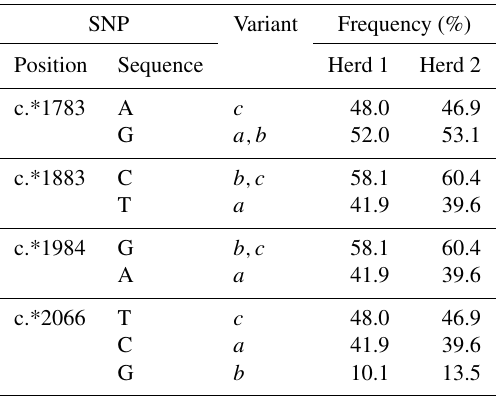
Table 1. Frequencies of SCD 3 (cid:48) -untranslated region SNPs in the two herds of cows